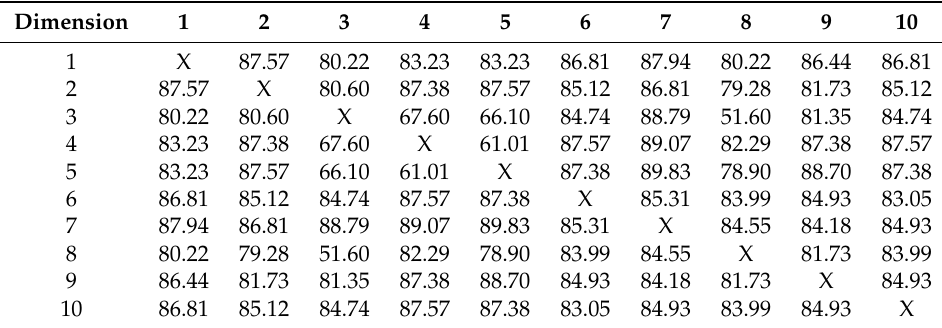
Table 6. Performance of 2D feature combination